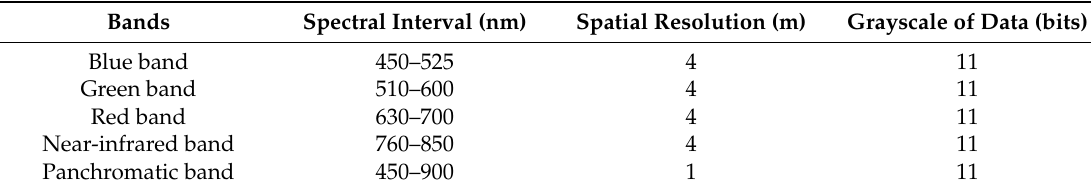
Table 1. Bands included in IKONOS image.